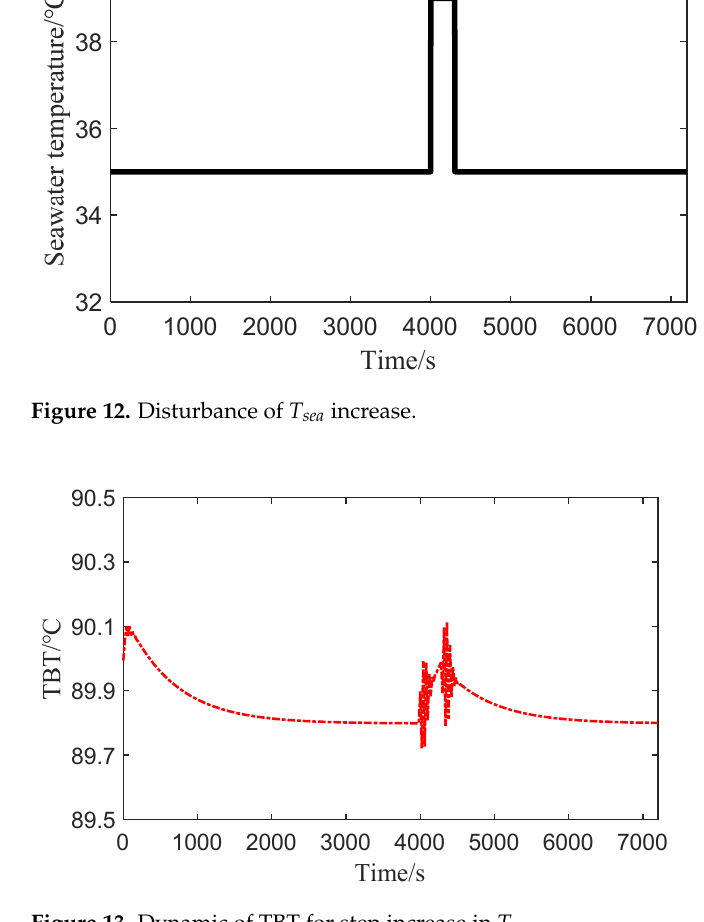
Figure 13. Dynamic of TBT for step increase in T sea .